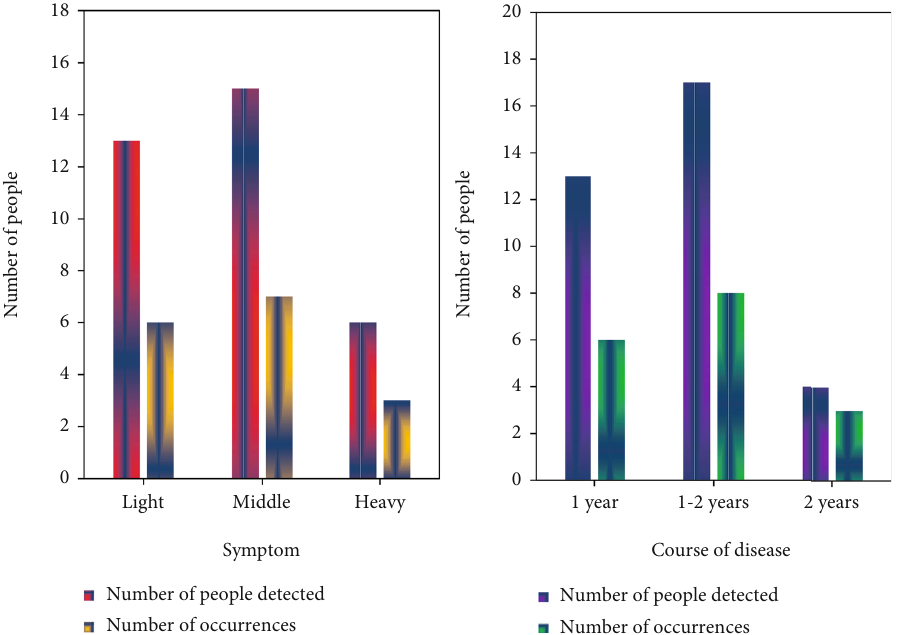
Figure 8: Comparison of the incidence of depressive symptoms (SDS) in patients with chronic prostatitis under di ff erent factors.